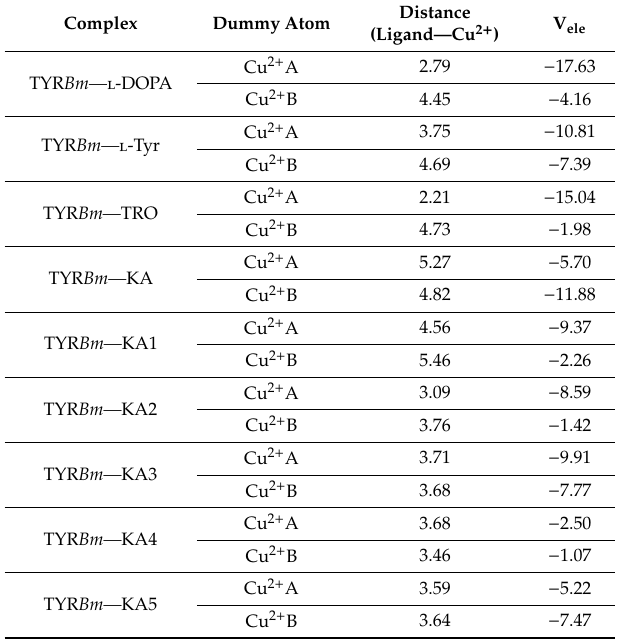
Figure 10. Average ligand–residue interaction energies (in kcal/mol) overall in compounds used in the linear interaction energy (LIE) calculations for the residues that contribute most to the ligand-surrounding electrostatic (dashed line) and (solid line) van der Waals. ( A ) TYR Bm -KA1 and ( B ) TYR Bm -KA5. The 3D structures of this figure are available in Protein Data Bank (PDB) format in the Supplementary Materials. Table 5. Electrostatic contributions (V ele , in kcal / mol) of Cu 2 + A and Cu 2 + B ions calculated by the linear interaction energy (LIE)